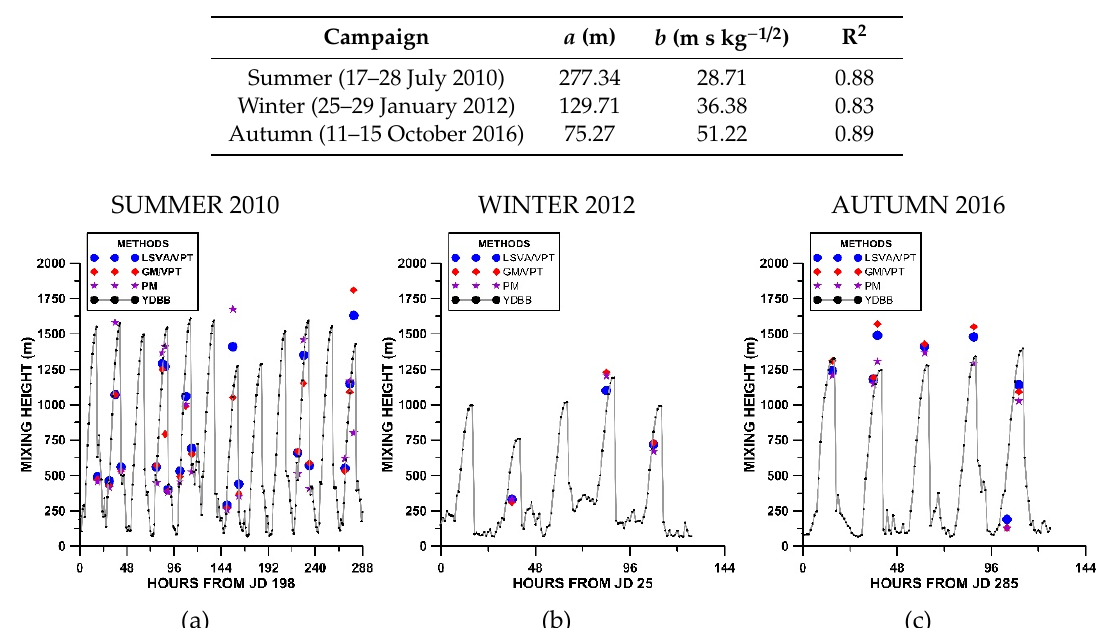
Table 10. Parameters of the Yi, Davis, Berger, and Bakwin (YDBB) model obtained from measurements of H 0 and estimations of mixing height from convective atmospheric soundings and surface measurements of friction velocity.